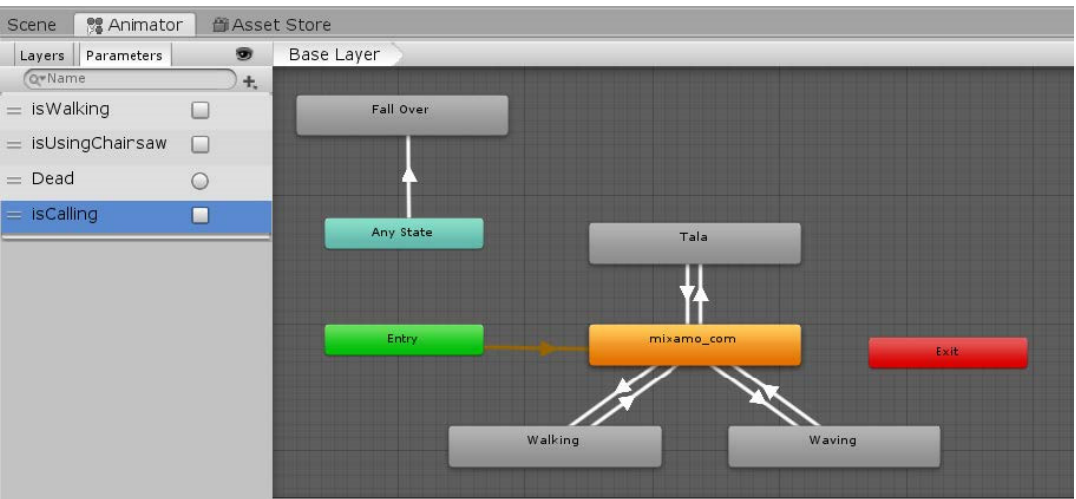
Figure 18. Situation tree correspondence with the VR platform state machine.